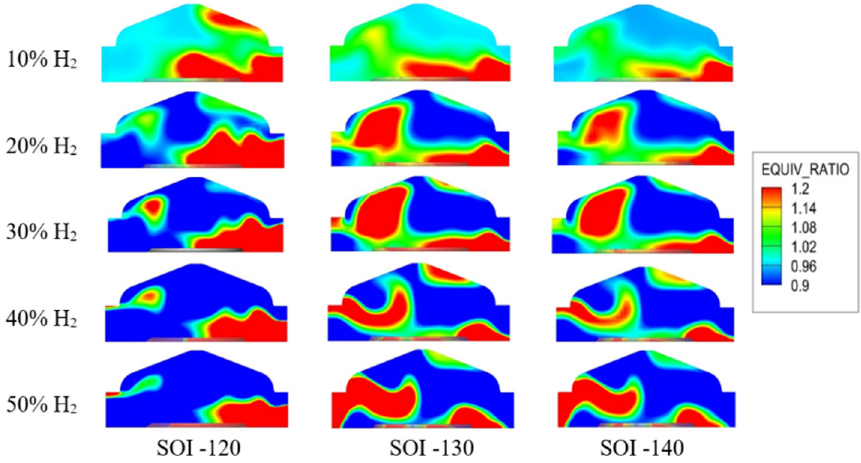
Figure 11. Contours of equivalence ratio for different case studies at − 40 CAD aTDC.